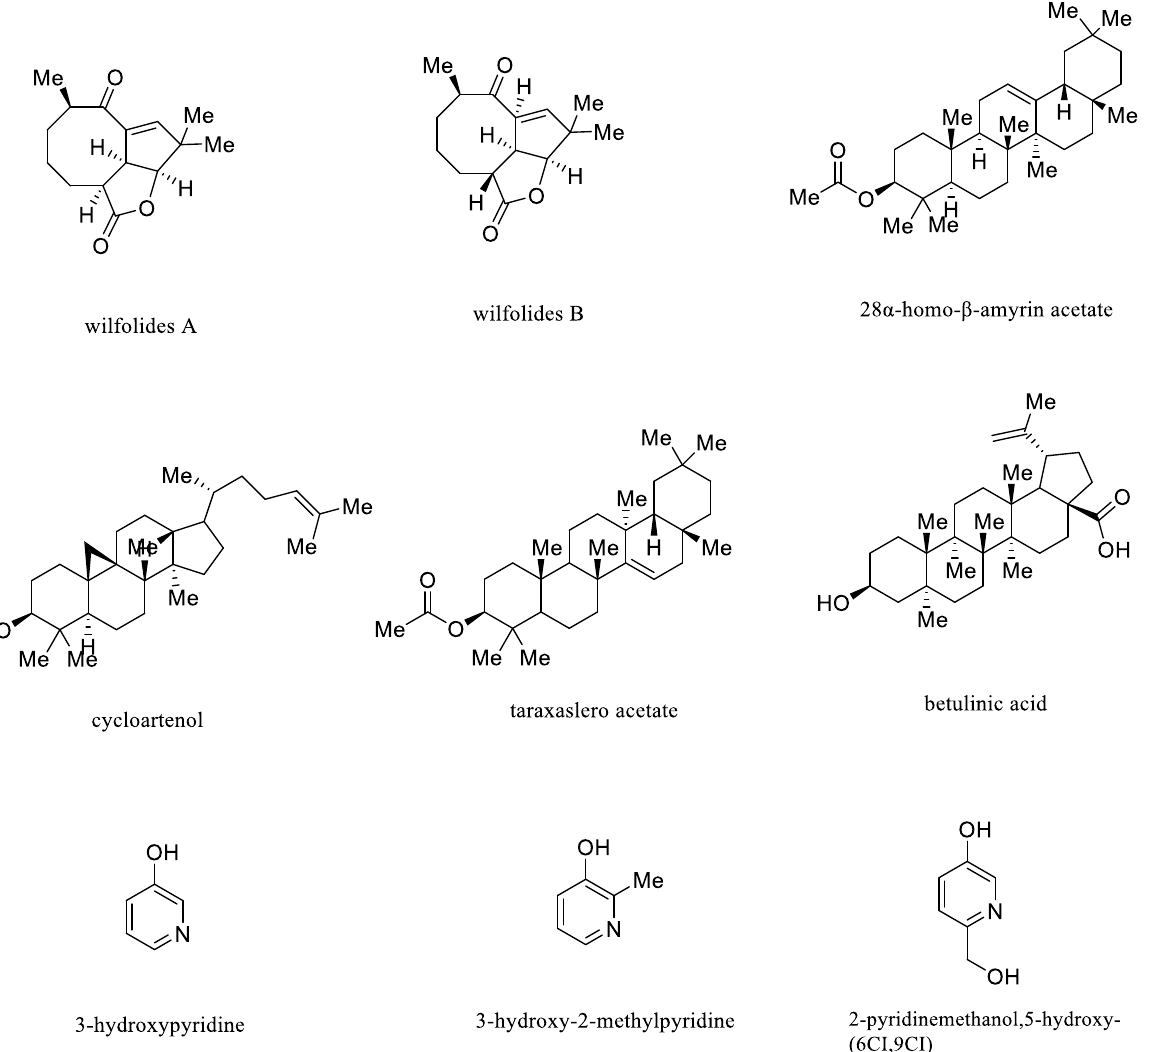
Figure 5. Representative structures of terpenoid and alkaloid compounds isolated from CA , CB and CW.